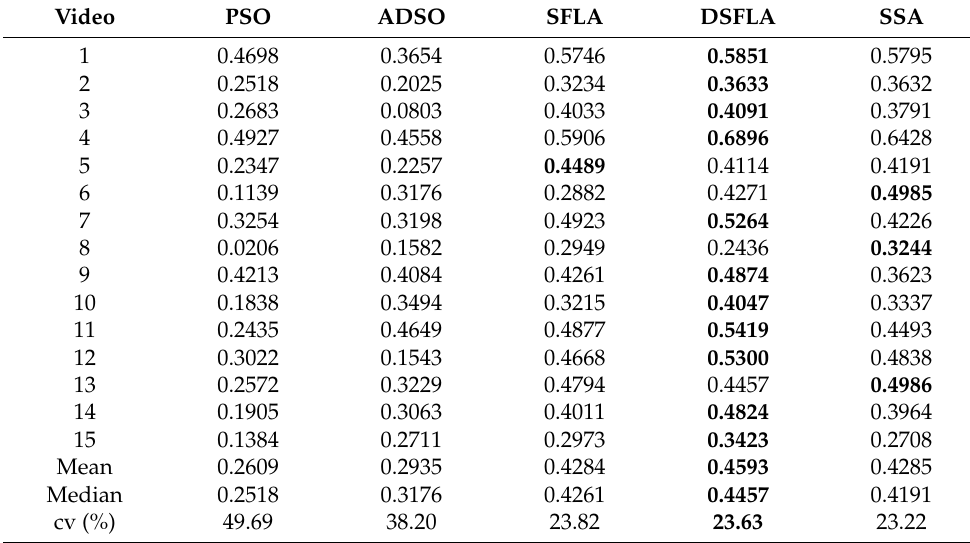
Table 4. AUC of the success rate per Pascal metric (the best results are in